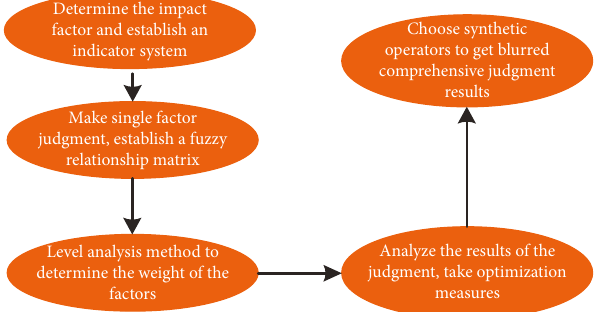
Figure 3: Fuzzy analysis structure